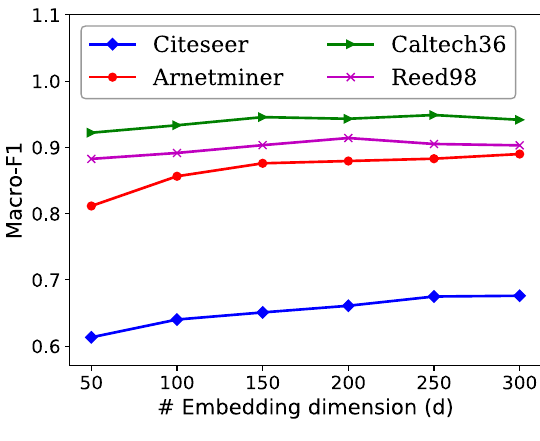
Fig. 4 Performance of node clustering